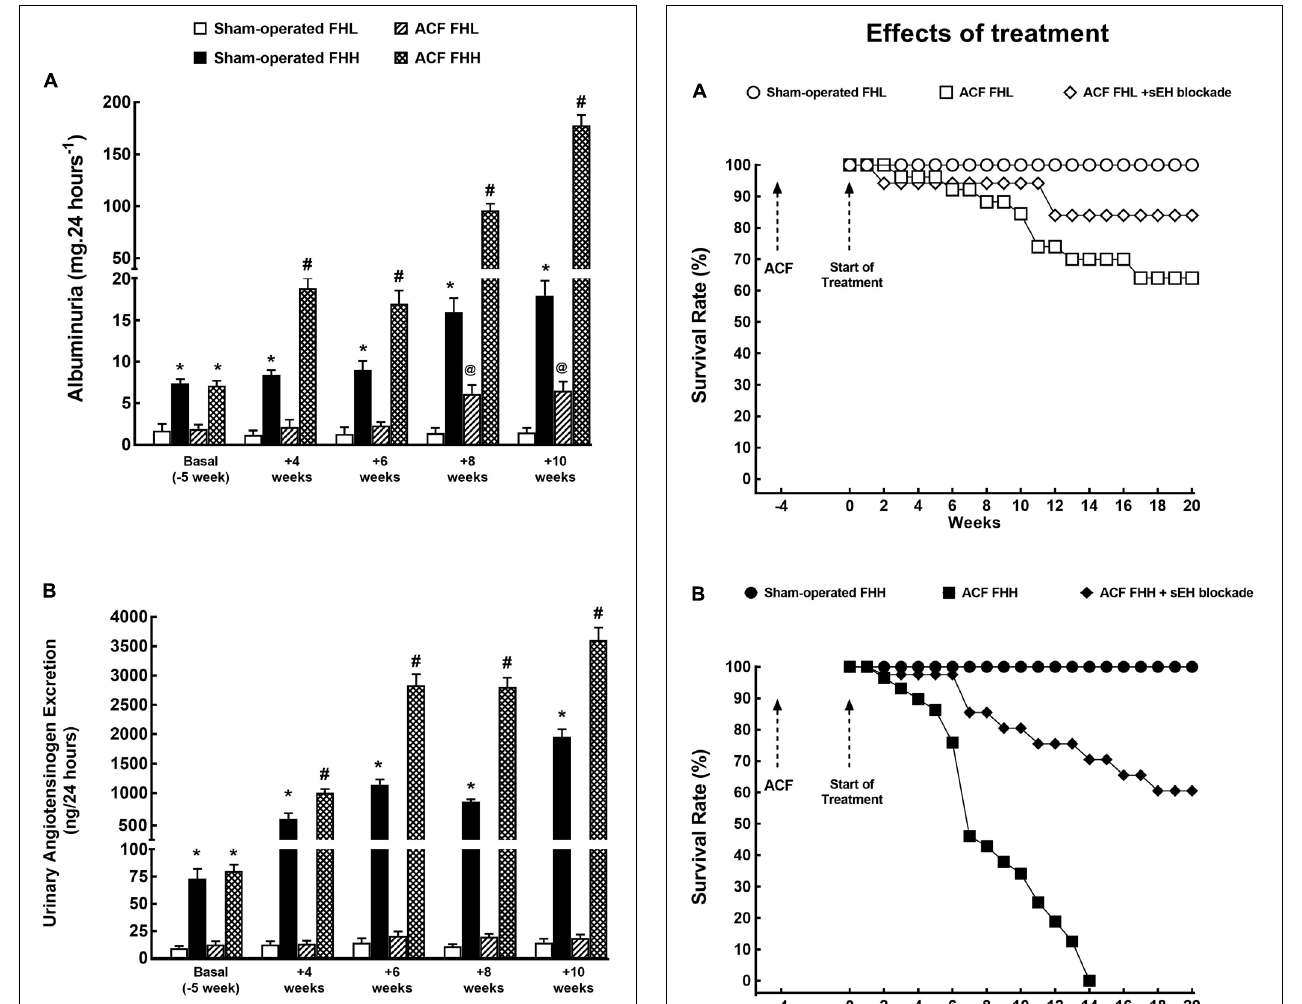
did not alter the course of urinary angiotensinogen excretion, similarly in ACF FHL and in ACF FHH